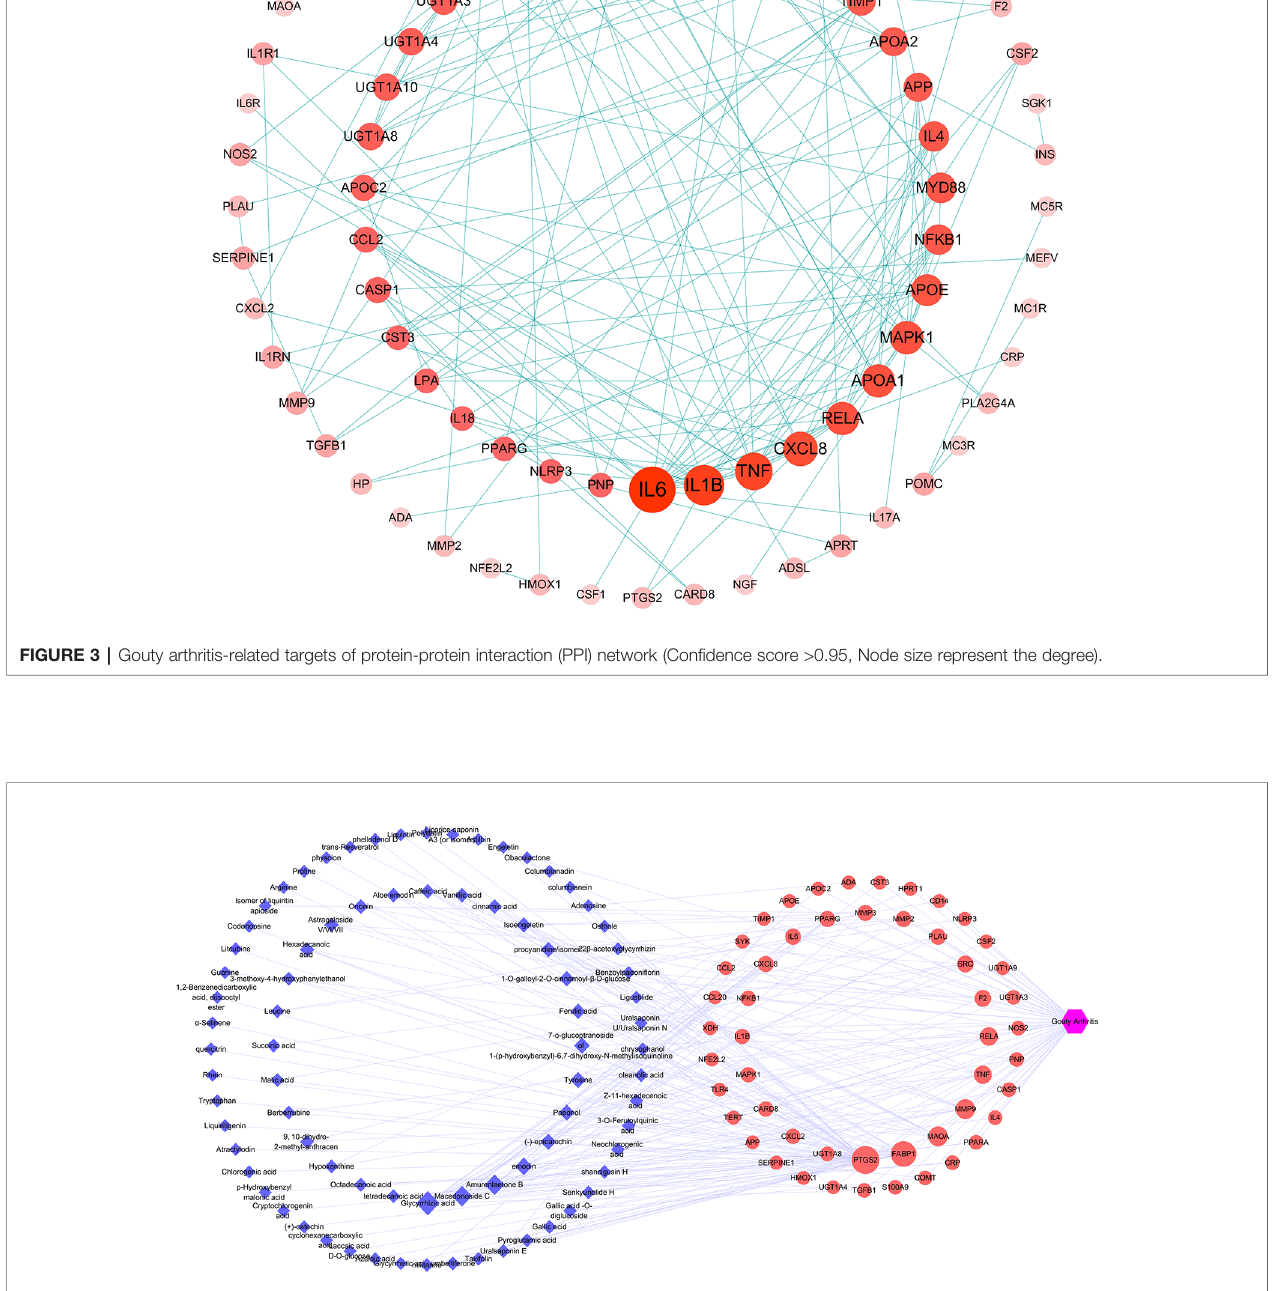
FIGURE 4 | Compound-potential targets-disease network (Blue diamond represents compound target; red circle represents pathway; purple hexagon represents